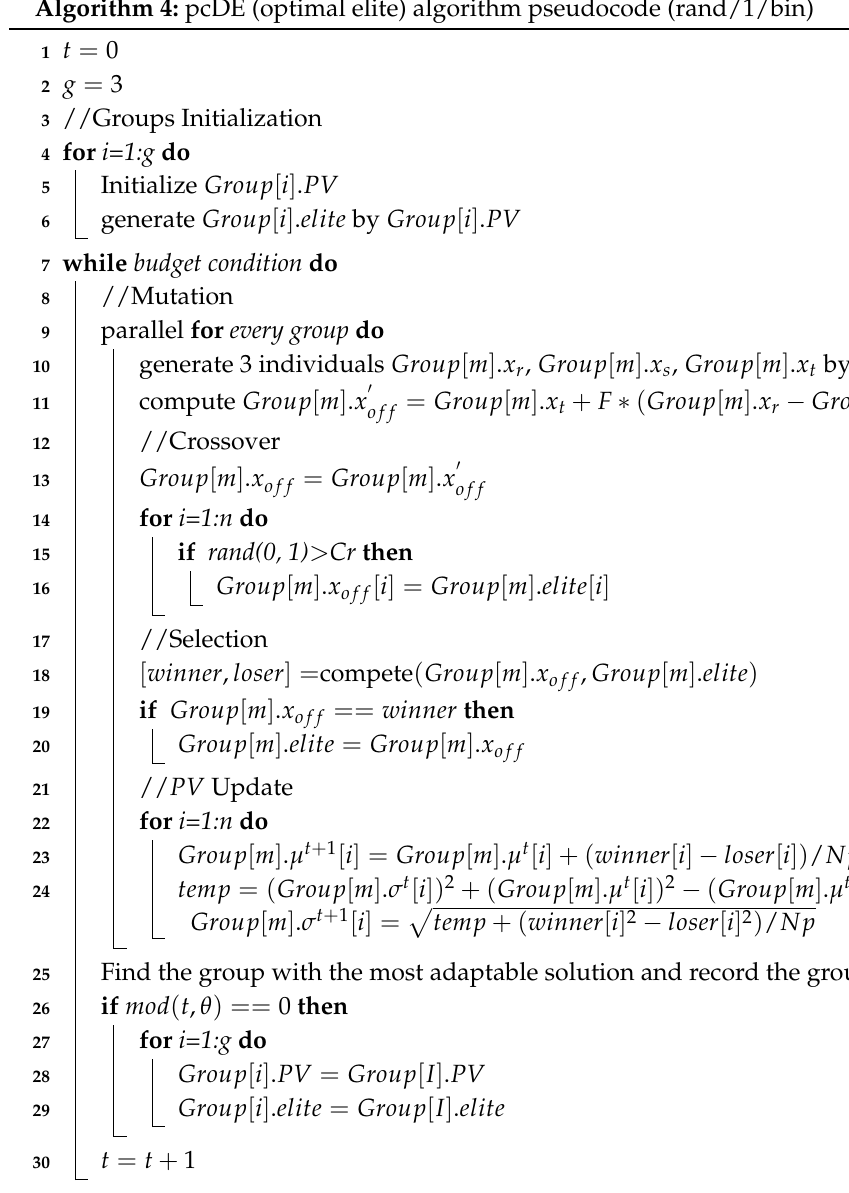
Algorithm 4: pcDE (optimal elite) algorithm pseudocode